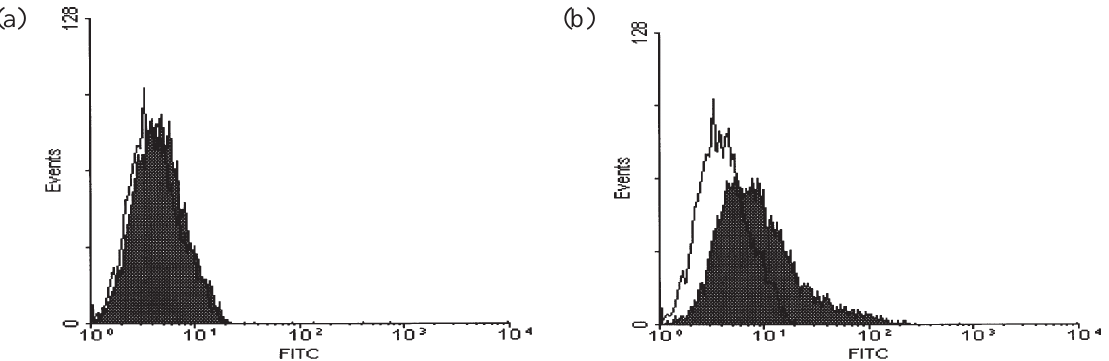
Fig. 3. Uniparametric histograms showing P-glycoprotein expression in CHO-K1 drug sensitive cells and in CHOVBR drug resistant cells. White areas represent the immunofluorescence distribution of the isotipic control. Reactive cells (shaded areas) were quantified by histogram substraction. (a) Fluorescence profile of CHO-K1 cells indicating C219 minimal staining (8%). (b) Detection of P-glycoprotein positive cells in CHOVBR